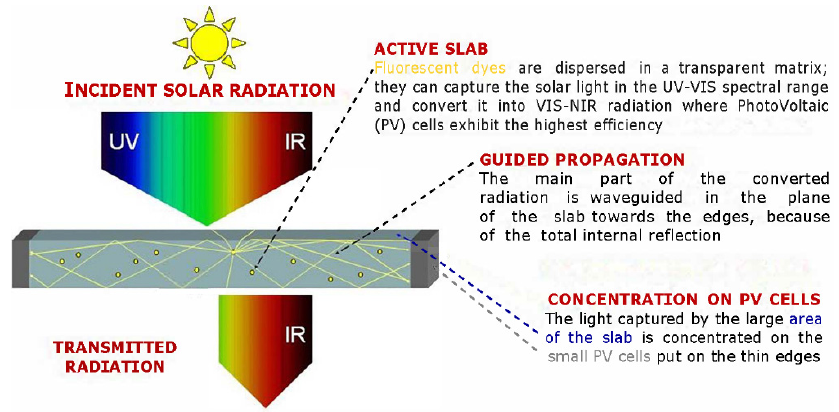
Figure 1. Diagram of incident photons and photons emitted by a dye molecule inside the Luminescent Solar Concentrator (LSC).